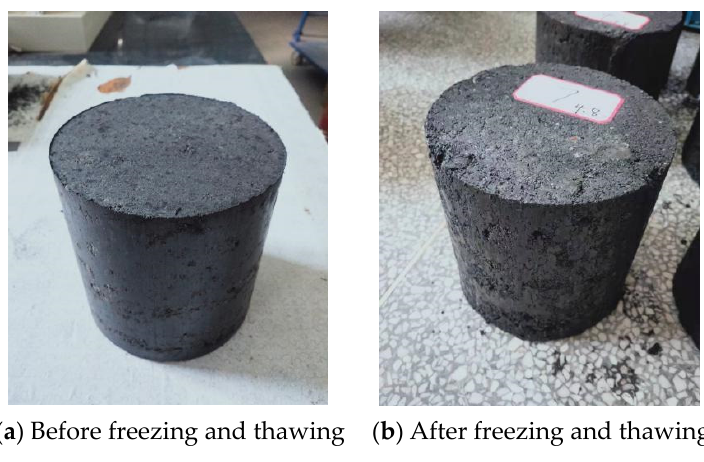
Figure 10. Freeze–thaw test process.